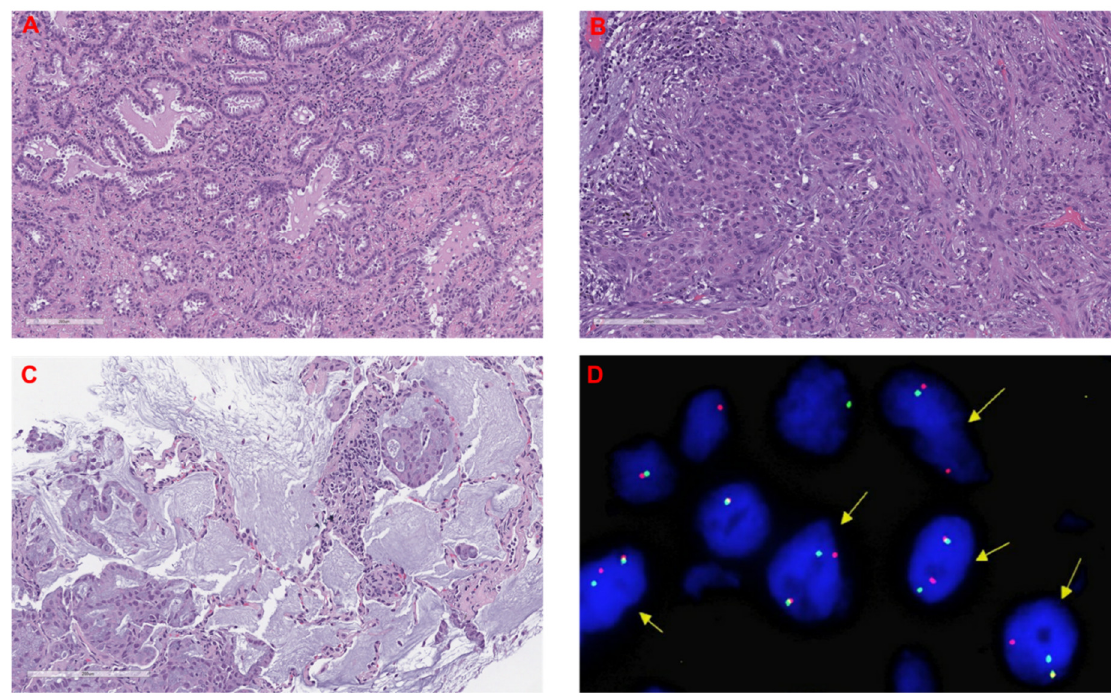
Figure 2. Representative pathological features of lung cancer. ( A ) Moderately differentiated adenosquamous carcinoma (from the first specimen of case #18); ( B ) Squamous cell carcinoma (from the second specimen of case #18); ( C ) Adenocarcinoma with mucinous differentiation and signet ring cell features (from the third specimen of case #19); and ( D ) ALK FISH image. Arrows indicate ALK rearrangement positive cells for typical split signal patterns (from the third specimen of case #19) (Magnification: 10X for histology; 100X for FISH).